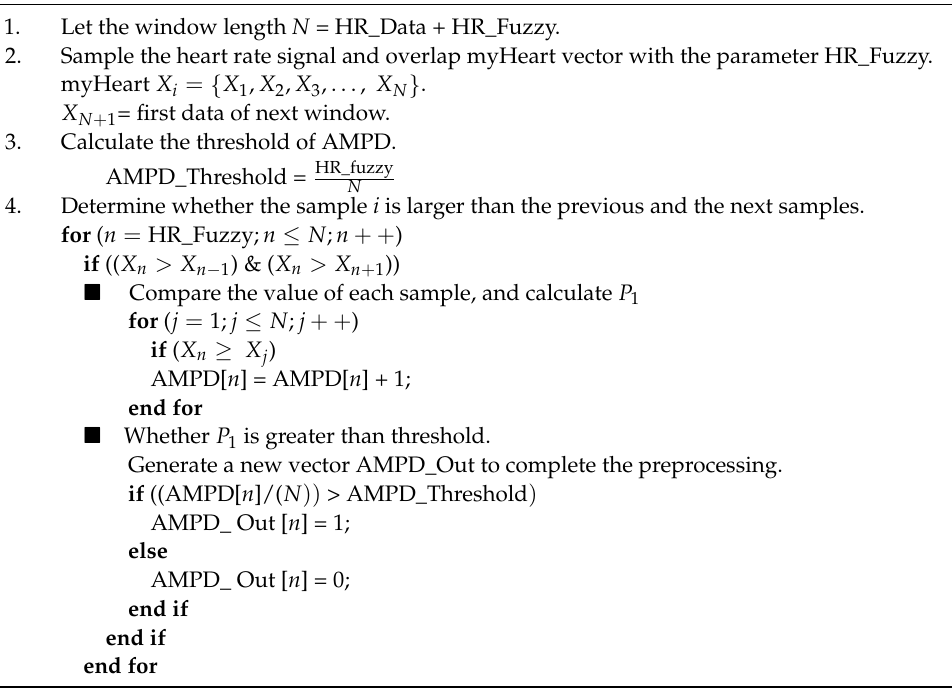
Algorithm 1. Comparison procedures of the AMPD-Fuzzy.